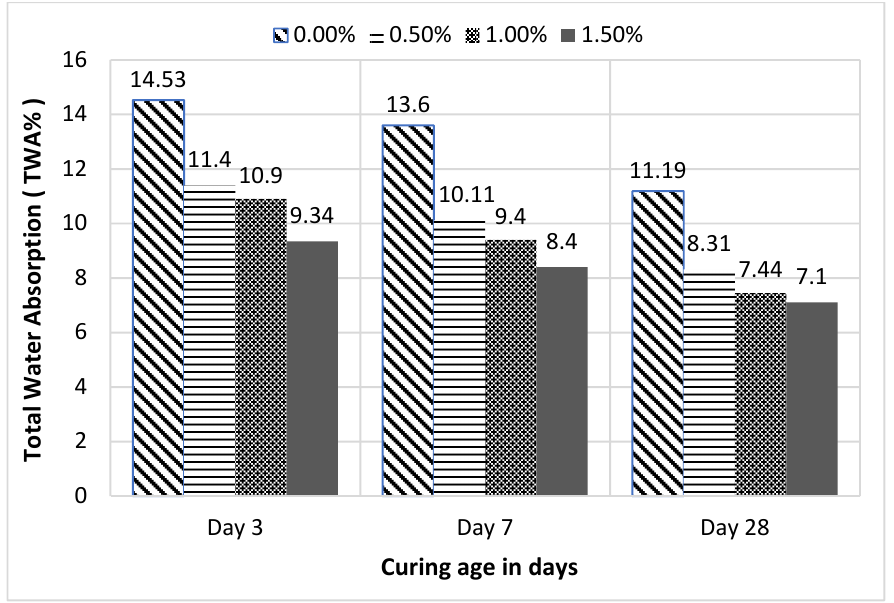
Figure 6. The effect of adding PA fibers on the total water absorption (TWA) of concrete mixes at 3, 7, and 28 days of curing.